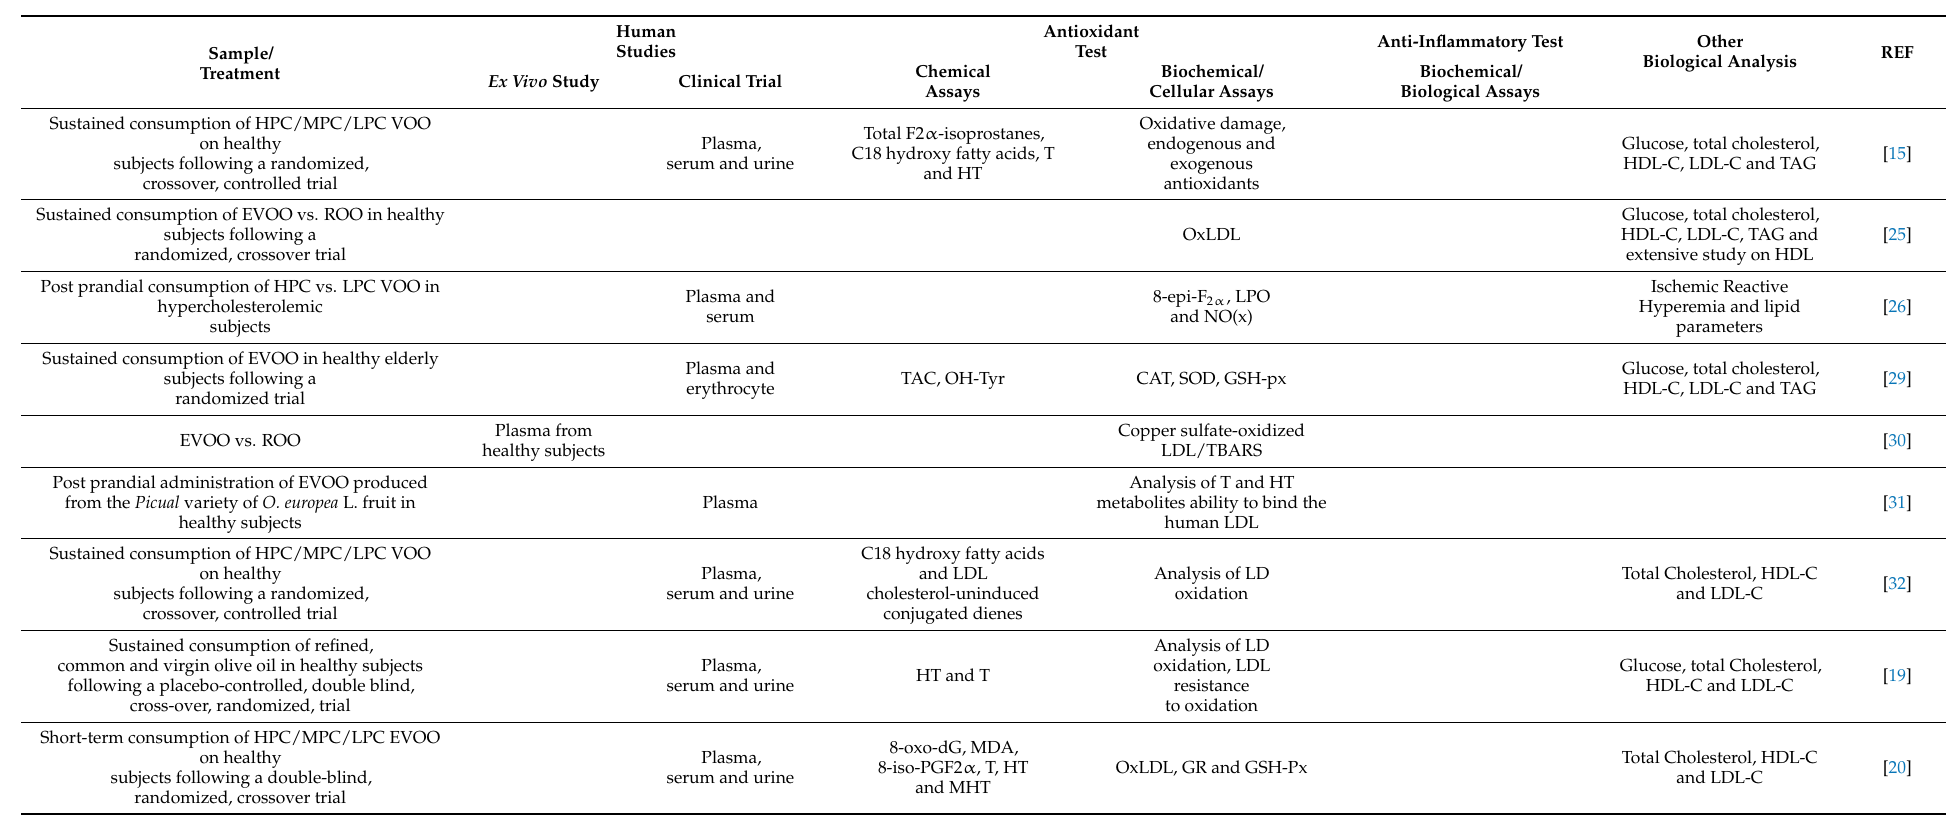
Table 1. Summary of human studies analyzing the antioxidant and anti-inflammatory properties of EVOO/VOO by a different combination of chemical, biochemical and biological assays, starting from the chemical characterization of the OO phenolic profile. 8-iso-PGF2 α : 8-epi-isoprostane prostaglandin F2 α ; ABTS: 2,2’-Azinobis-(3-ethylbenzothiazoline-6-sulfonic acid); ALT: alanine transaminase; AST: aspartate transaminase; CAT: catalase; CRP: C-reactive protein;